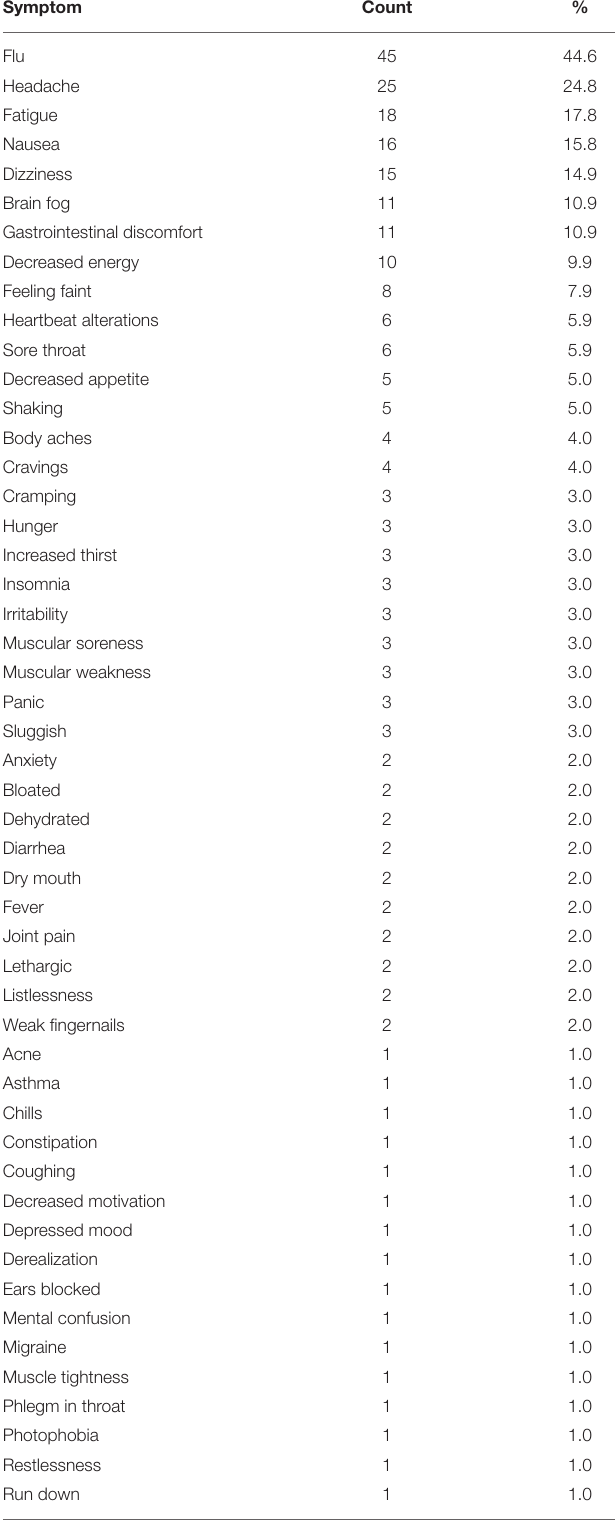
TABLE 1 | Glossary of symptoms of keto flu derived from online forum posts, with counts and